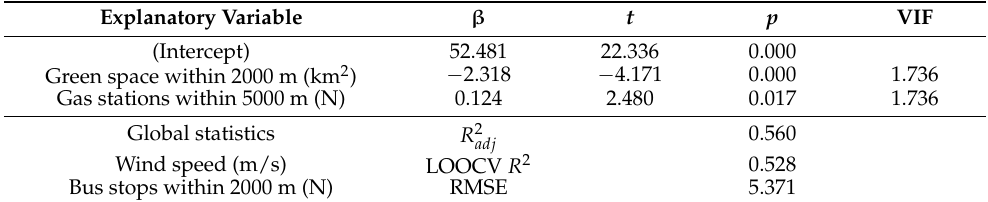
Table 7. Final results of the NO 2 model for the morning peak (7 a.m.–9